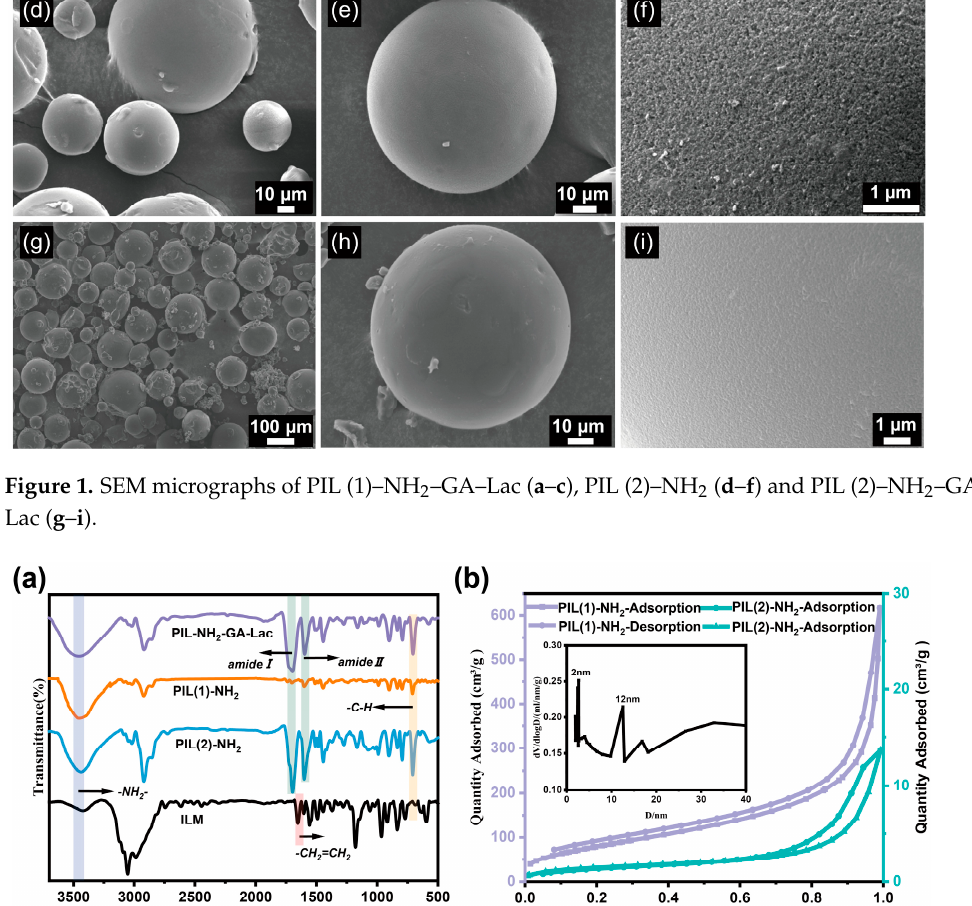
Figure 1. SEM micrographs of PIL (1)–NH 2 –GA–Lac ( a – c ), PIL (2)–NH 2 ( d – f ) and PIL (2)–NH 2 –GA– Lac ( g – i ).